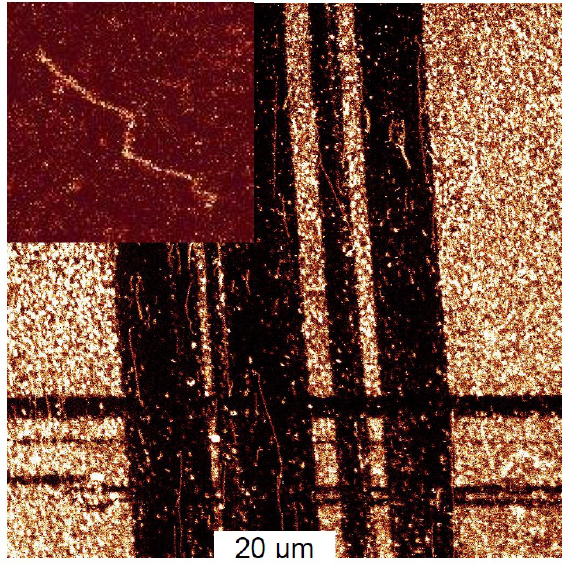
Figure 3: Luminescence scanning image recorded by CLSM of gold particles rich area (bright) gold particle poor area (dark). Pulsed (140 ns) excitation at 700 nm, emission recorded in the range 380– 680 nm. Long and shorter luminescence tracks are visible, going to- ward the lower right. Upper left insert: example of electron track in- dicating several elastic collisions in the oil medium, which changes its direction